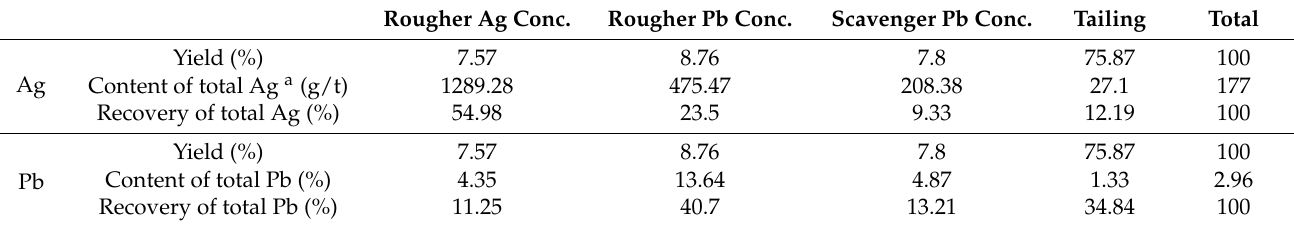
Table 3. The yield, grade, and recovery of total Pb and